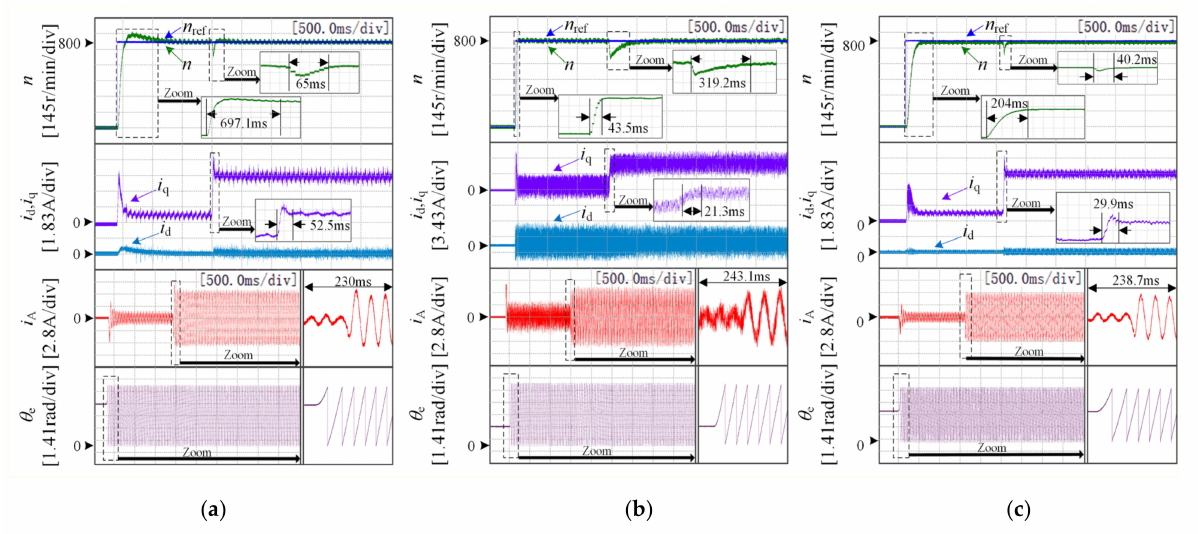
Figure 4. Comparison results of the proposed algorithm with DOB-FOC and DOB-PSC. ( a ) DOB-FOC. ( b ) DOB-PSC. ( c )